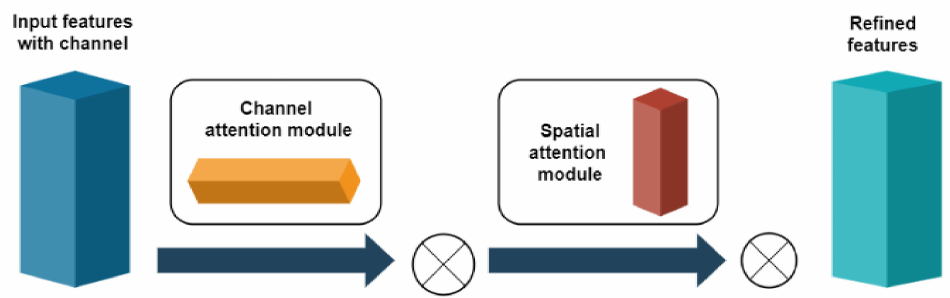
Figure 4. The structure of the CBAM attention